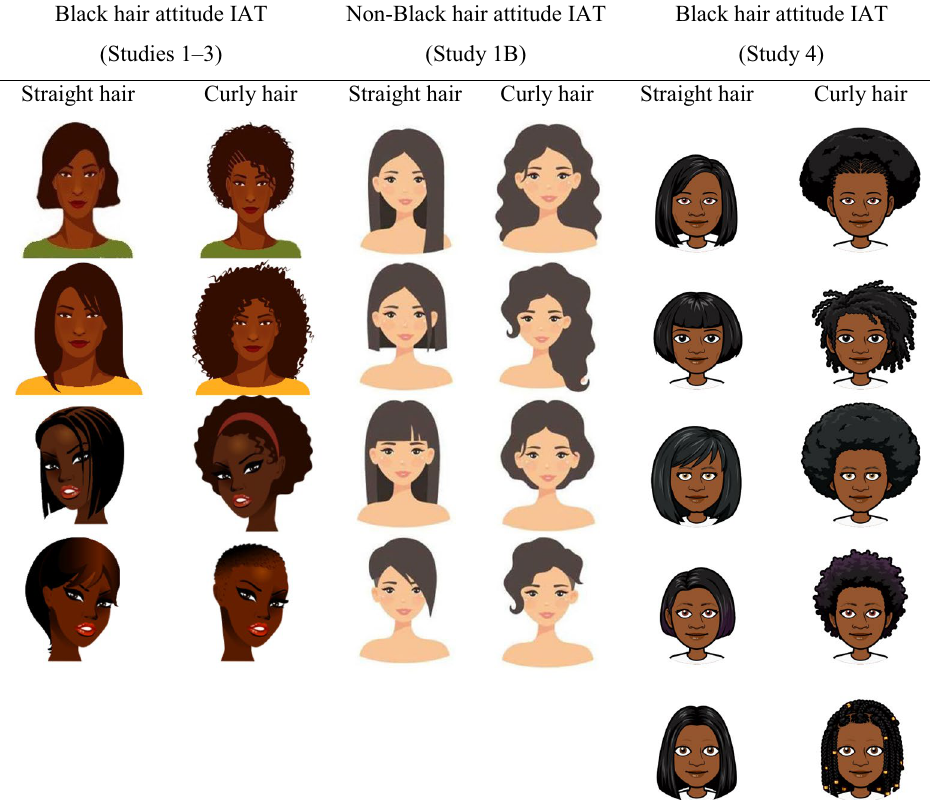
Black hair attitude